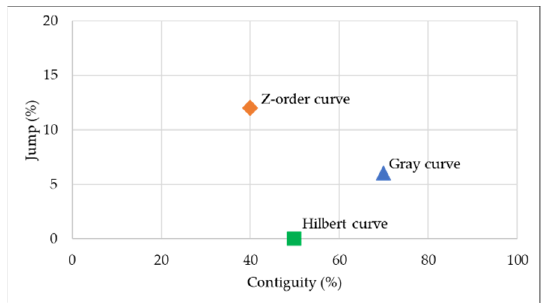
Figure 3. Jump and Contiguity percentages comparison of Hilbert curve, Gray curve and Z-order curve.